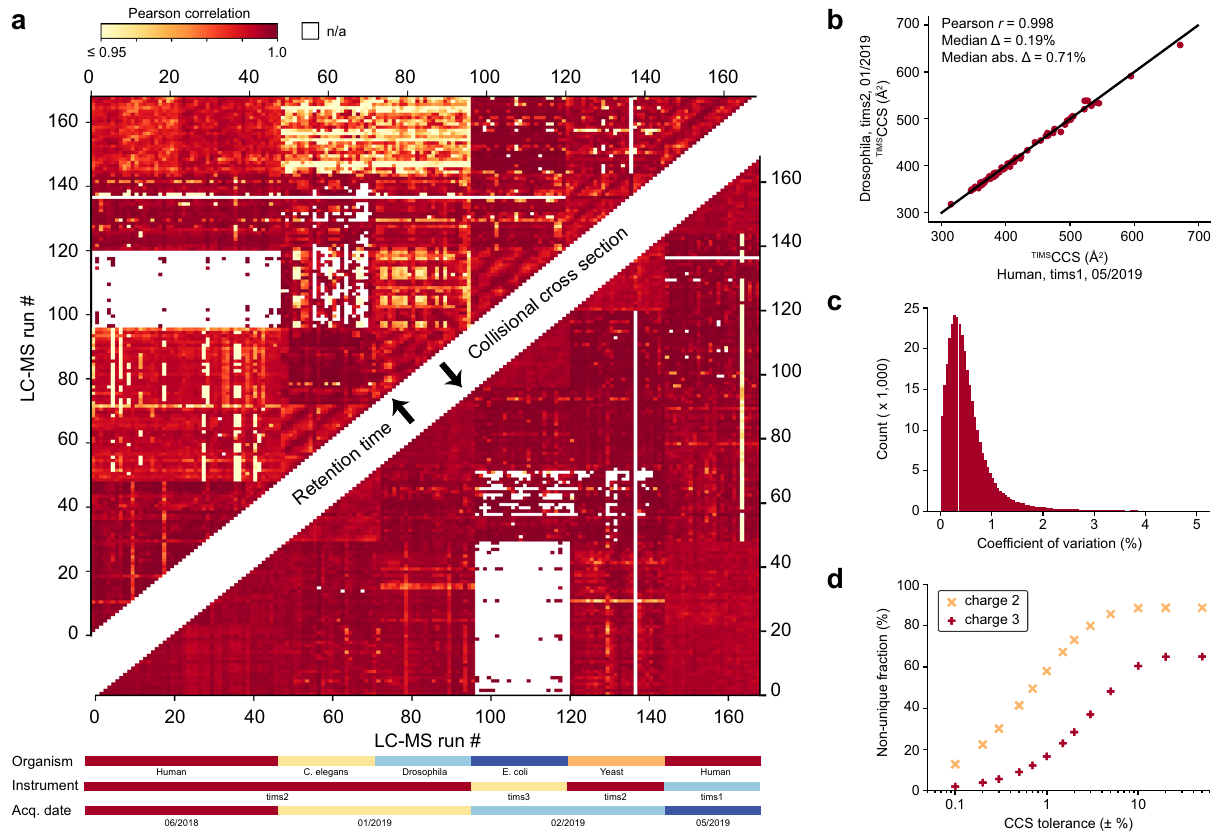
Fig. 2 Precision, accuracy, and utility of experimental peptide CCS values. a Color-coded pairwise Pearson correlation values of peptide retention time (upper triangular matrix) and CCS values (lower triangular matrix) between the 168 LC-MS/MS runs of fractionated tryptic digests. Experimental metadata are indicated below the x -axis. White (n/a) indicates less than 5 data points for pairwise comparison. b CCS values of shared tryptic peptides independently measured in two typical LC-MS runs of fractions from Drosophila and HeLa ( n = 68). c CVs of repeatedly measured peptide CCS values in the full dataset ( n = 347,885 peptides). d Speci fi city of combined peptide m/z and CCS information for doubly and triply charged peptides with C-terminal arginine or lysine ( n = 324,246 and 112,015) with a fi xed m/z tolerance of ±1.5 ppm and as a function of CCS tolerance. For details, see main text and